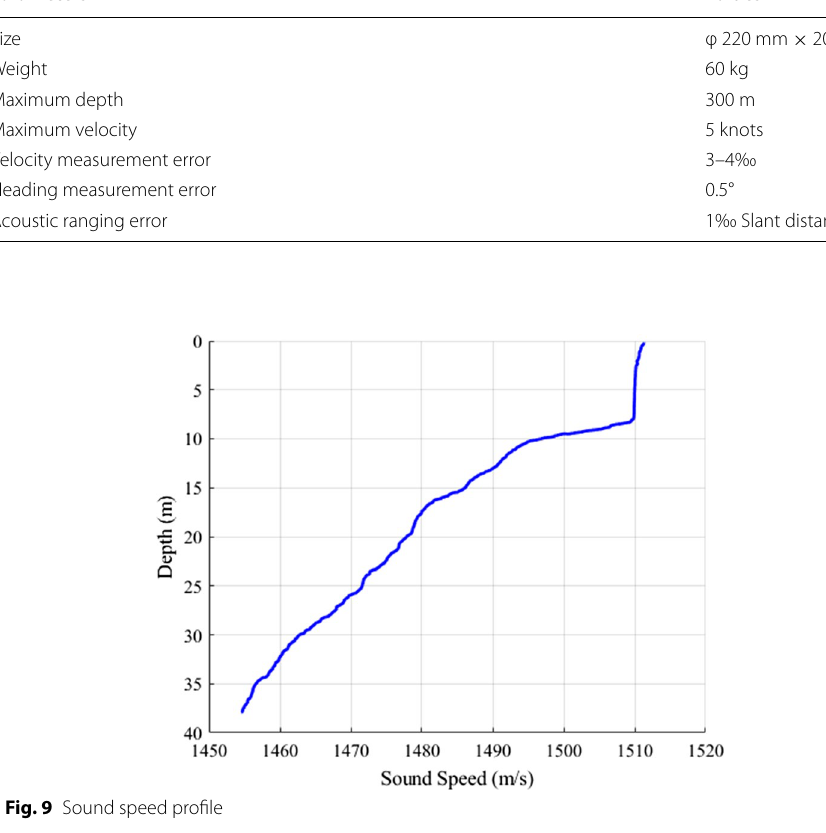
Table 2 Parameters of the AUV